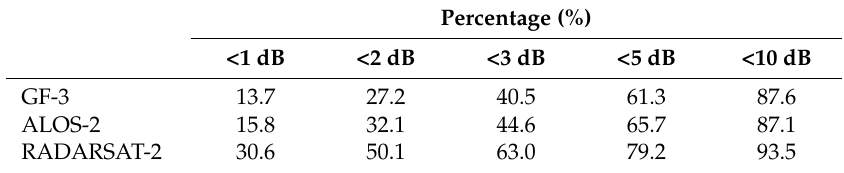
Figure 3. Histograms of the difference between 𝜎 (cid:3009)(cid:3023)(cid:3042) and 𝜎 (cid:3023)(cid:3009)(cid:3042) for GF-1703 ( a ), A2-1603 ( b ), and R2- ( c ) over Beijing. Table 2. The proportion of pixels with differences between 𝜎 (cid:3009)(cid:3023)(cid:3042) and 𝜎 (cid:3023)(cid:3009)(cid:3042) lower than specific values.